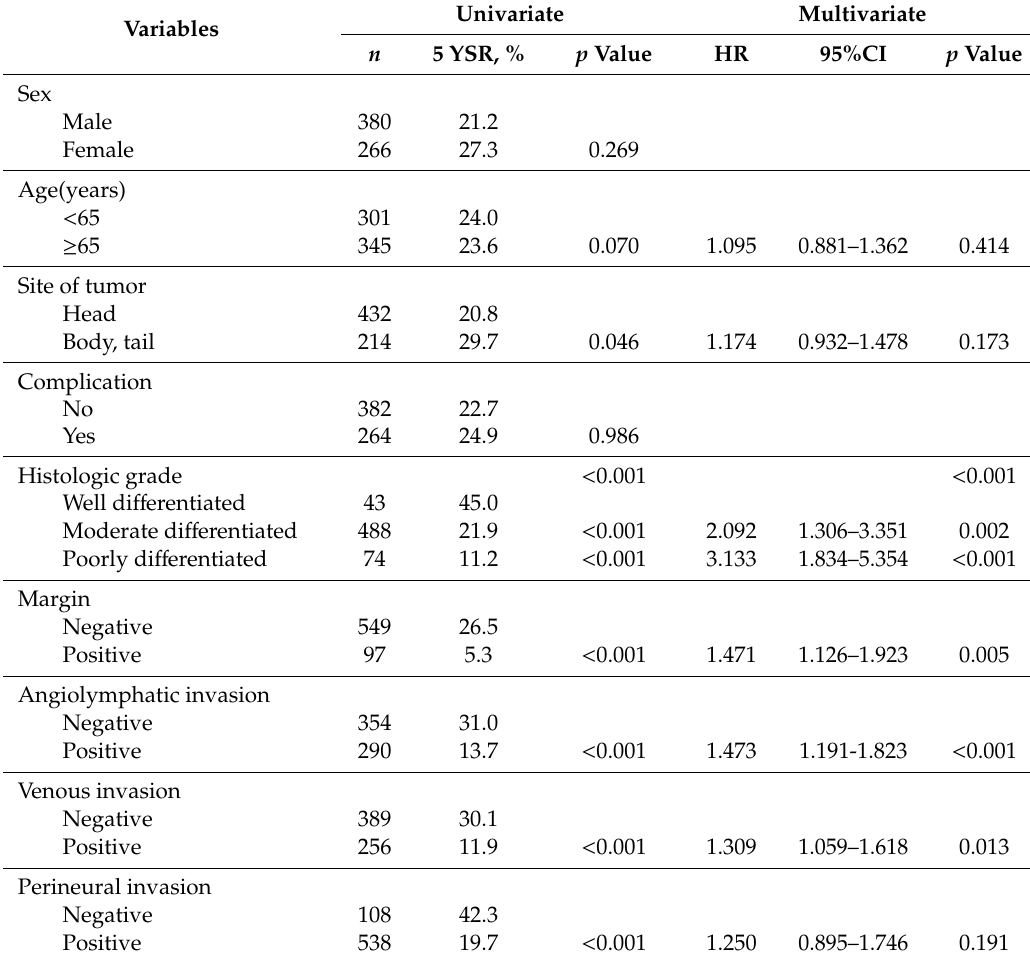
Table 3. Univariate and multivariate analysis comparing the 5-year survival rates in resected patients. Univariate Multivariate Variables n 5 YSR,